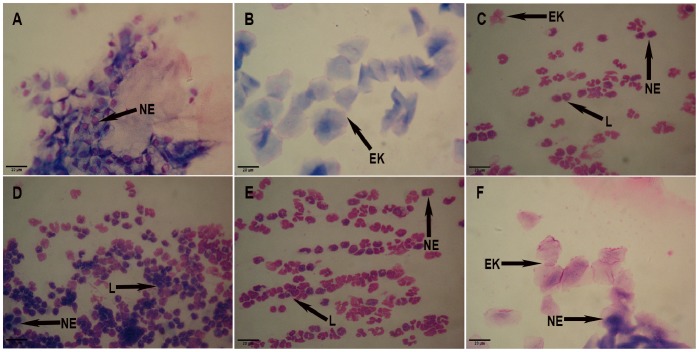
The vaginal smears of rats in the control, PCOS, and PCOS EA groups.Rats’ vaginal smears were stained with Wright’s stain, as described in the Materials and Methods section. A) The representative rat’s vaginal smears from the control group in proestrus (A×200). B) The representative rat’s vaginal smears from the control group in estrus (B×200). C) The representative rat’s vaginal smears from the control group in metestrus (C×200). D) The representative rat’s vaginal smears from the control group in diestrus (D×200). E) The representative rat’s vaginal smears from the PCOS group predominantly exhibited leukocytes, the main cell type observed during the diestrus stage (E×200). F) The representative rat’s vaginal smears from the PCOS EA group exhibited epithelial keratinocytes, the main cell type observed during the estrus stage (F×200). NE: nuclear epithelial cell, EK: epithelial keratinocyte, L: leukocyte. Scale bar, 20 µm.